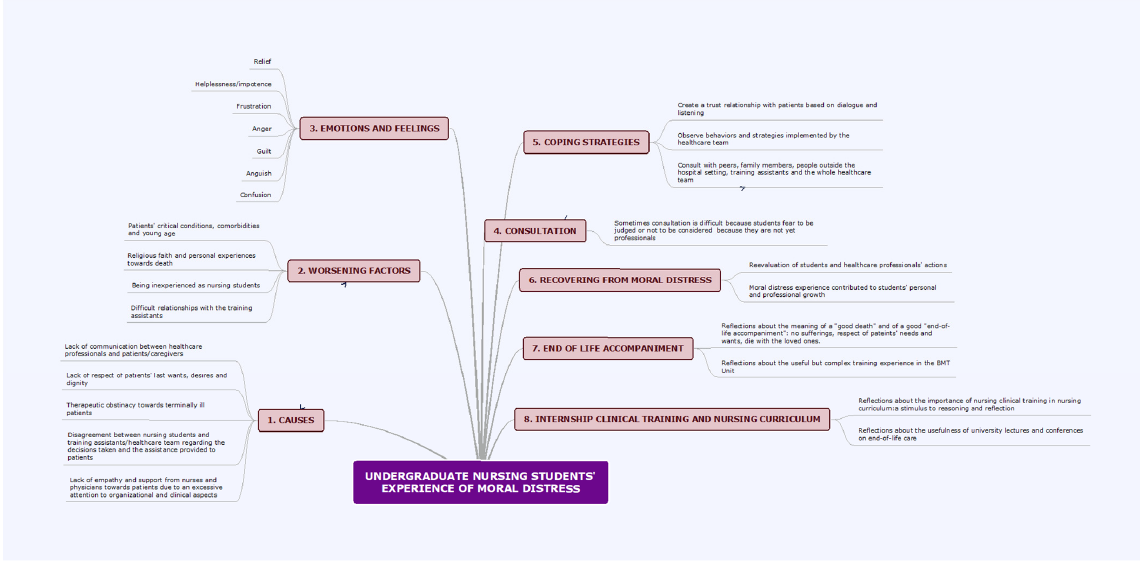
Figure 1. Concept